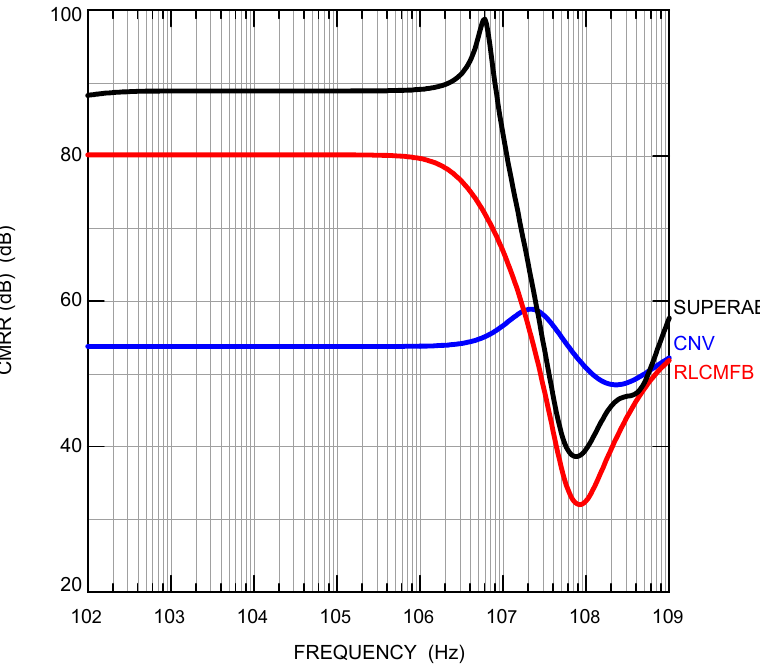
Figure 12. CMRR of super class AB OTA of Figure 10, of RLCMFB OTA of Figure 3b and of conven- tional OTA of Figure 3a simulated with I BIAS = 5 µA.